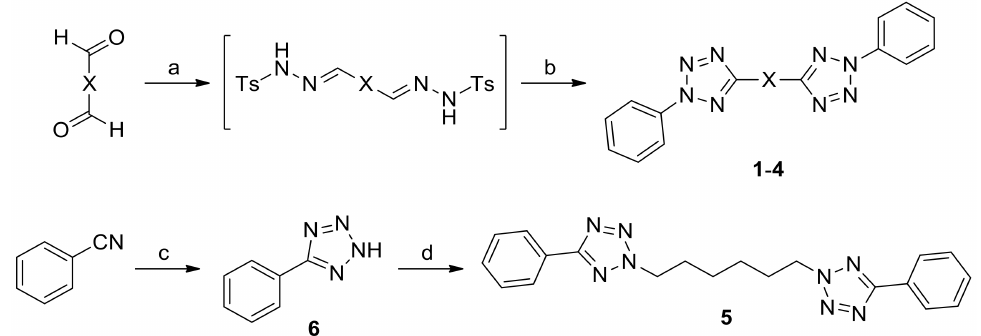
Scheme 2. Synthesis of bistetrazoles 1–5 . Reagents and conditions: ( a ) p -toluenesulfonyl hydrazide,